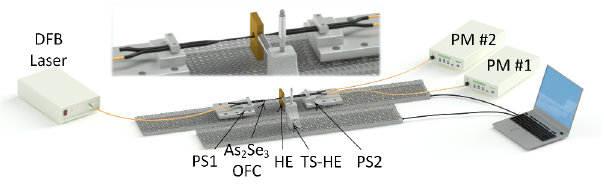
Figure 1. Schematic of the tapering setup. PS: pulling stage; HE: heating element; TS-HE: translation stage of the heating element; PM: power